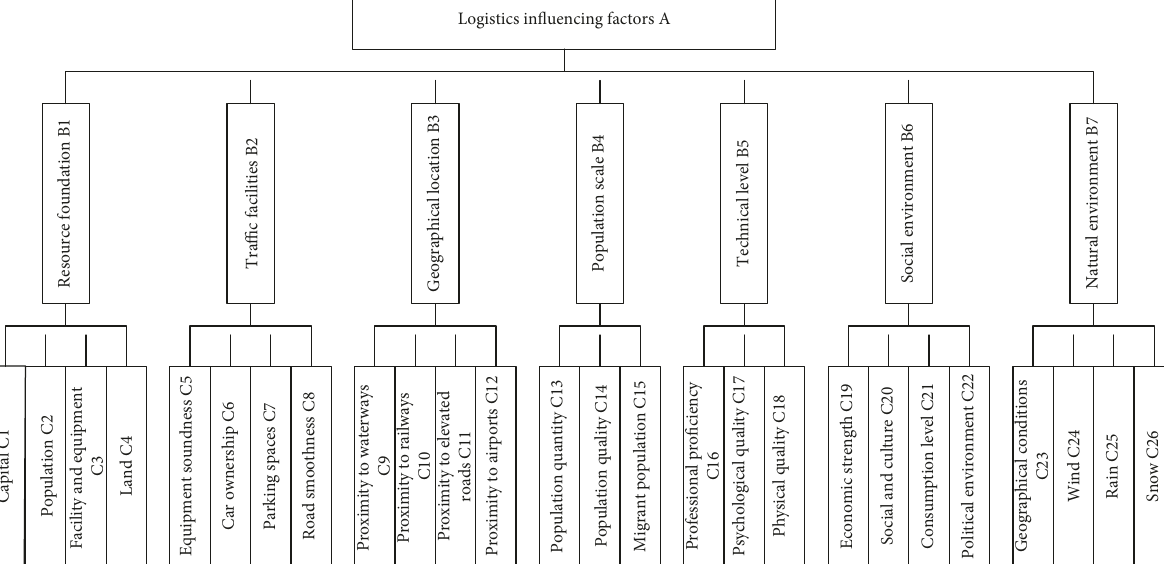
Figure 2: Hierarchical evaluation model for logistics influencing factors.